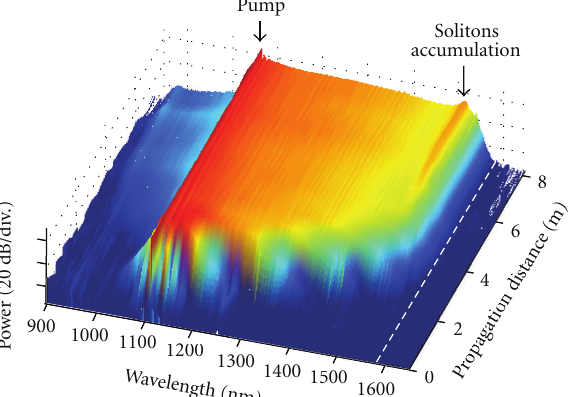
Figure 9: Experimental dynamics of the SC formation as a function of launched pump peak power. The white dashed line represents the PBG